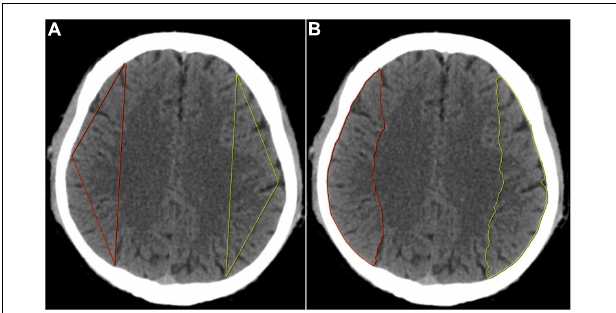
FIGURE 1 | (A) Determination of the three vertexes in triangular contour was selected in the semioval center level. The anterior vertex was selected at the intersection of the longitudinal centerline of the unilateral cerebral hemisphere and the frontal cortex, the posterior vertex at the parietal cortex, and the middle vertex was selected at the midpoint of the convex surface of the brain, then the three points were connected in a straight line to form a triangular contour. (B) Determination of the semiautomatic contour was also selected in the semioval center level. The anterior and posterior points were selected with the same method as triangular contour and then the two points were automatically connected and the convex edge of the cerebral hemisphere was automatically outlined to form a semiautomatic